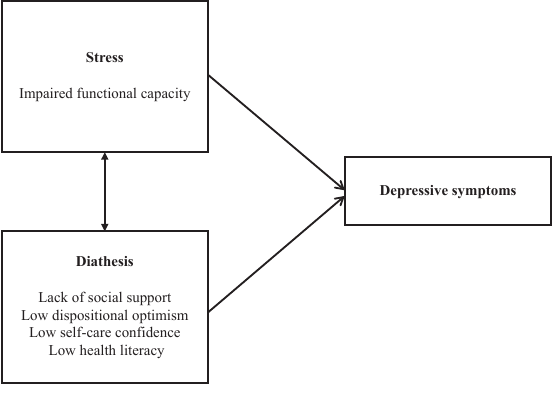
Figure 1. The conceptual model guiding this